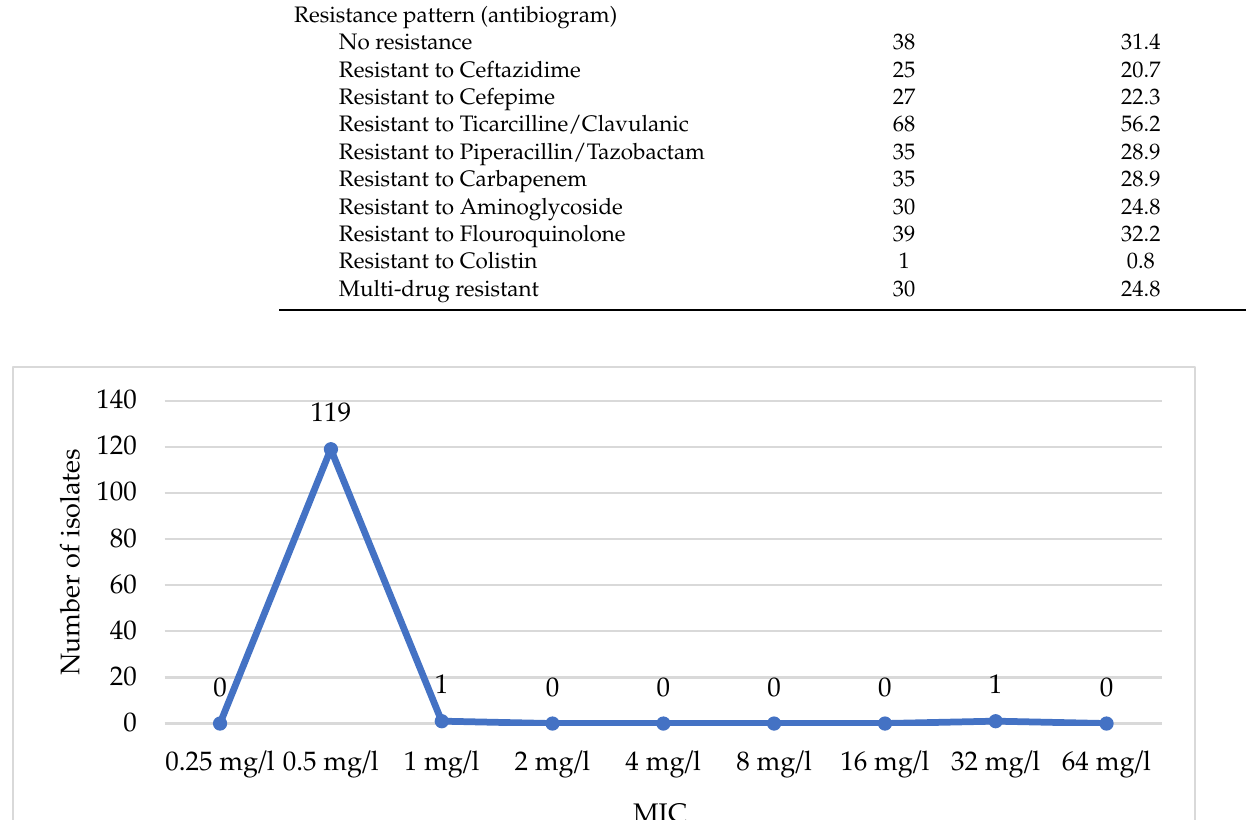
Figure 1. Minimum inhibitory concentration ( MIC) distribution of colistin among P . aeruginosa isolates.